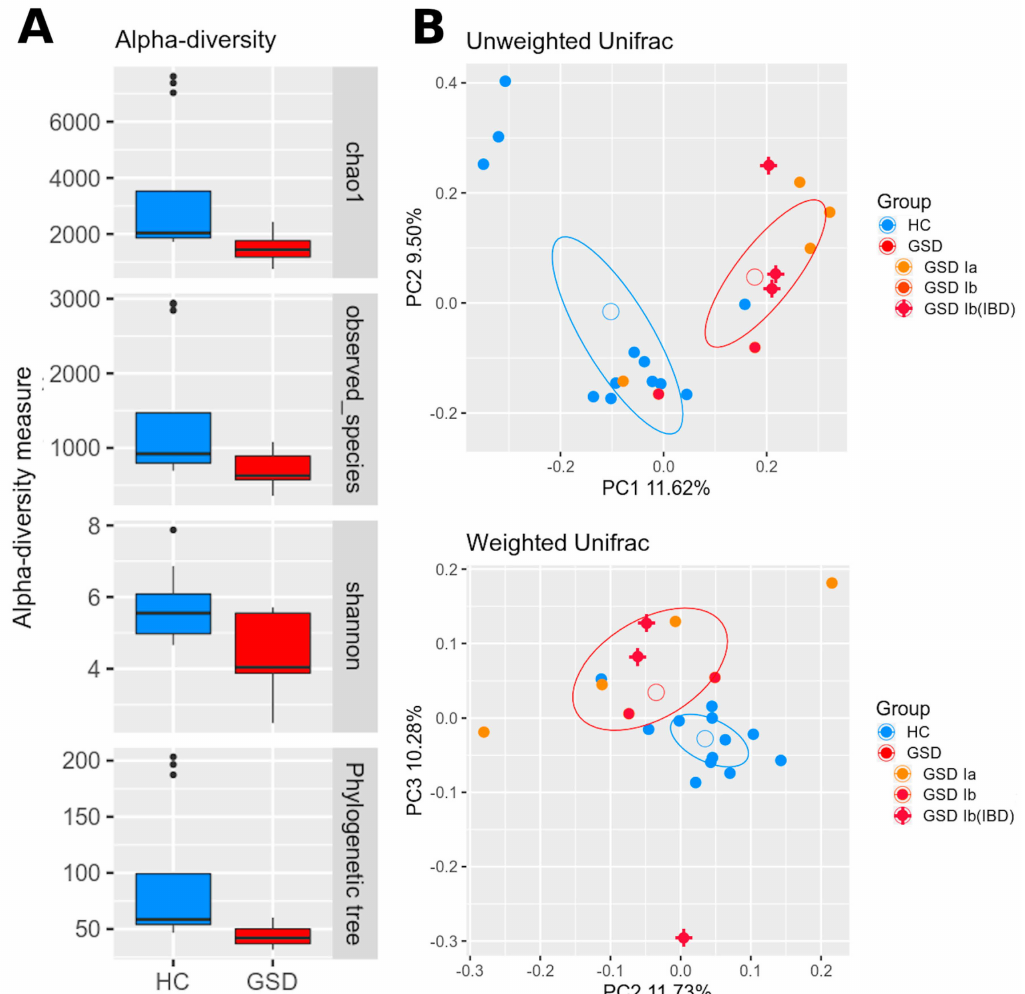
Figure 1. Biodiversity and phylogenetic analysis between cohorts. ( A ) Alpha-diversity indexes are reported for healthy control (HC) (blue) and glycogen storage disease (GSD) (red) subjects for chao1, observed species, Shannon diversity and Faith’s phylogenetic metrics. Diversity among groups is statistically significant for all metrics. ( B ) Beta-diversity analysis represented by PCoA graphs of weighted and unweighted UniFrac distance between HC (blue) and GSD (red) subjects. The ellipses of mean standard error (SEM)-based data confidence are reported. Microbial communities are statistically di ff erent for both distances (adonis test: unweighted p = 0.004; weighted p = 0.01). Percentage variance accounting for the first, second and third principal components is shown along the axis. To highlight possible di ff erences related to GSD type, a color scheme was further applied to the GSD group: GSD-Ia (orange), GSD-Ib (red), GSD-Ib with inflammatory bowel disease (IBD) (red +